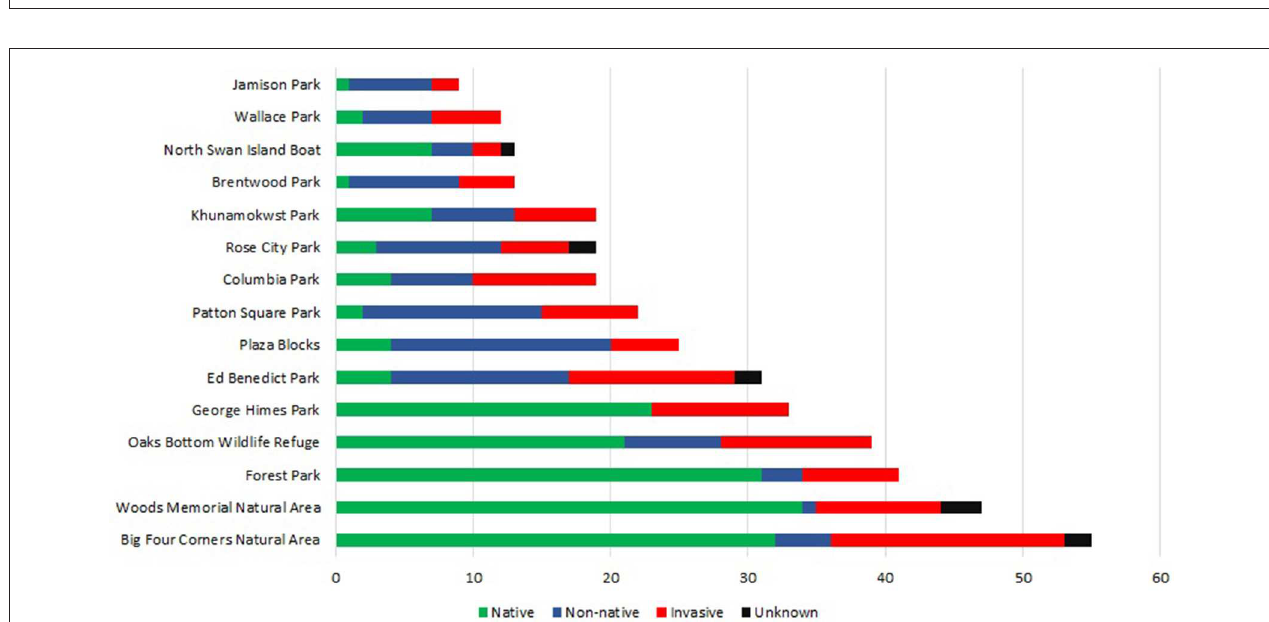
FIGURE 3 | Number of plant species by